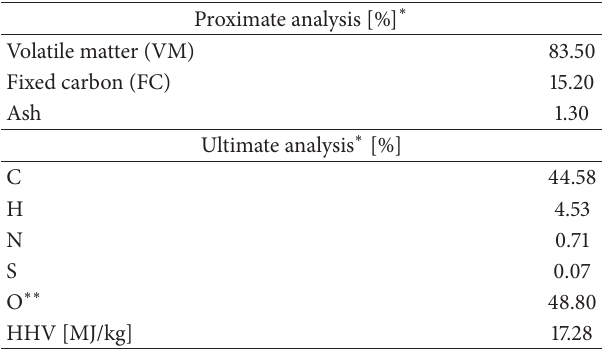
Table 1: Physical and chemical properties of OPF